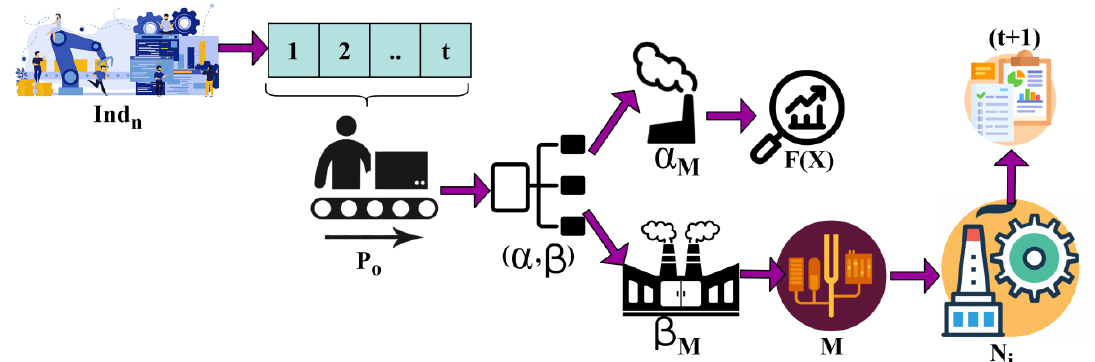
Figure 2. Mimicking Operation.